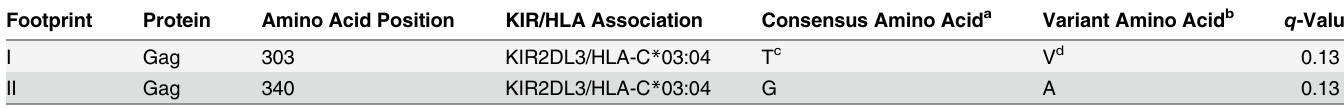
Table 1. KIR footprints in HIV-1 clade C